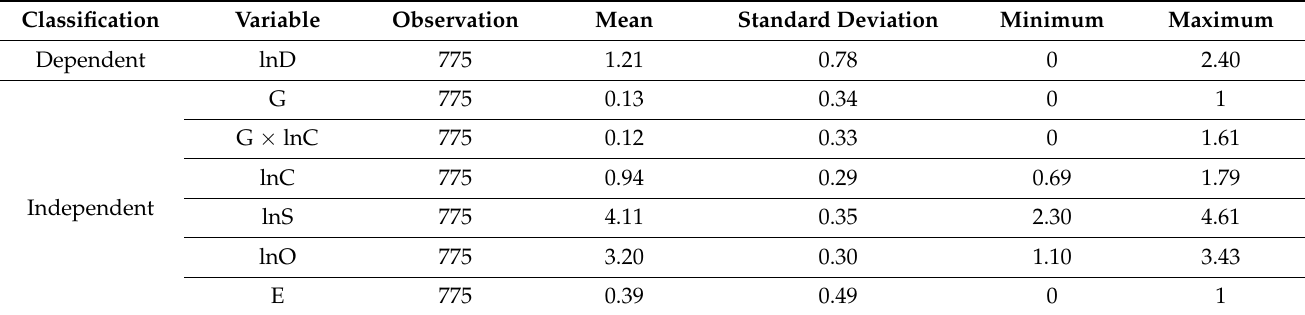
Table 3. Summary